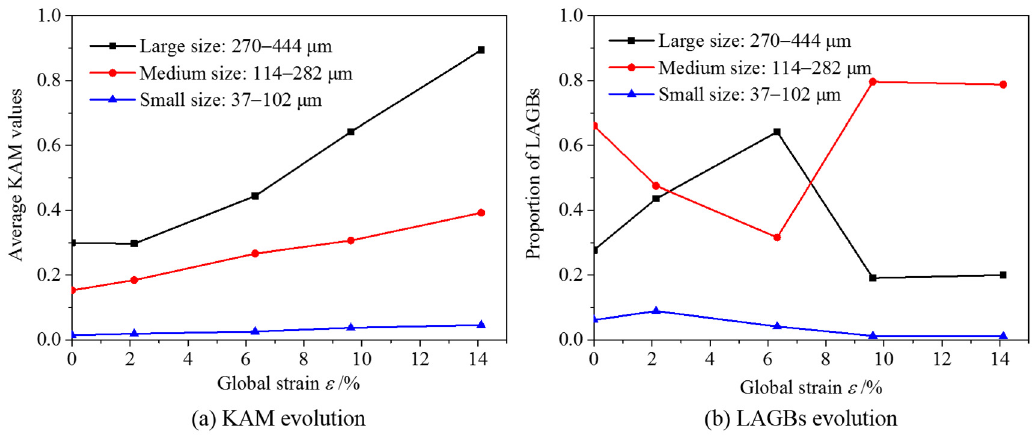
Figure 9. KAM and LAGBs evolutions of the observable field observed by EBSD.